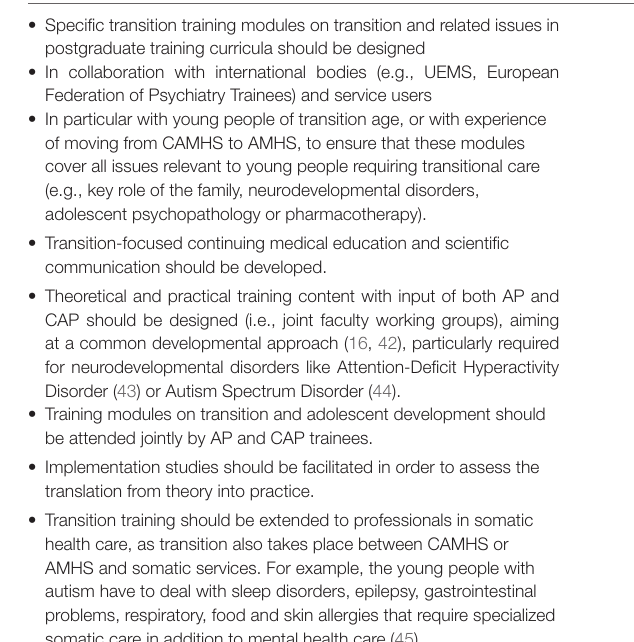
TABLE 4 | Recommendations for improved training to transition